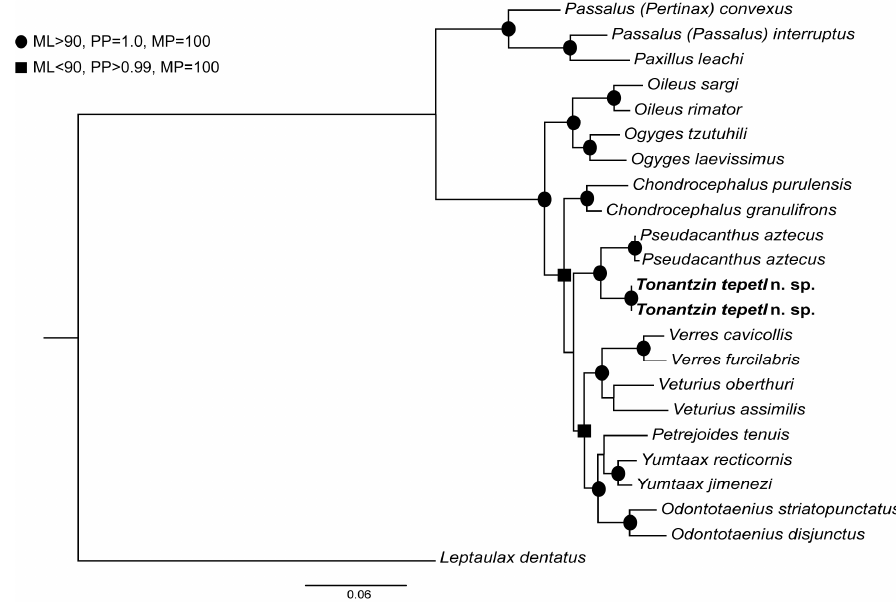
Figure 2. Maximum likelihood tree resulting from the partitioned analysis. Nodal support is indicated for relationships with strong statistical